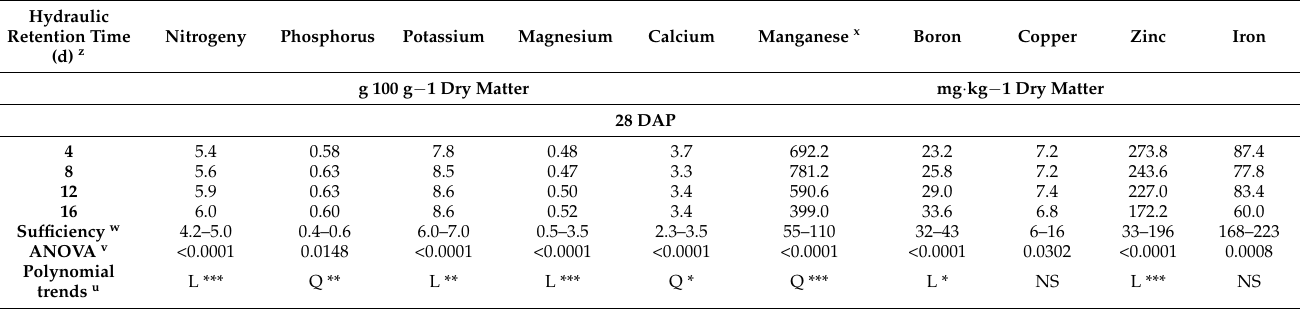
Table 4. Selected foliar nutrient concentrations of ‘Rex’ butterhead lettuce ( Lactuca sativa ) HRT without iron supplementation, simple effects of HRT for final